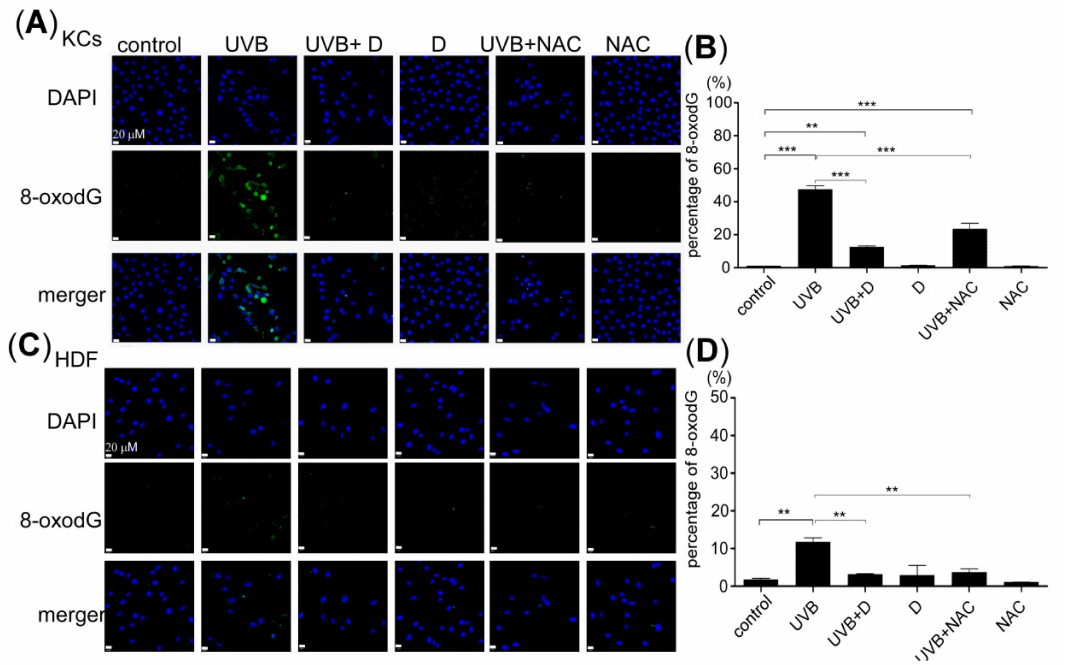
Figure 6. The effect of Derinat on the UVB-induced DNA damage in skin cells. 8-oxodG was detected to determine the DNA damage resulting from UVB-exposure in cells pretreated with Derinat and NAC: ( A ) KCs and ( C ) HDF. The relative values of DNA damage from 8-oxodG are quantified in ( B , D ) (**, p < 0.01; ***, p < 0.001). The data shown represent the average of three independent